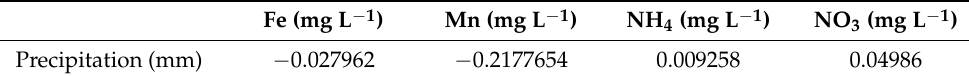
Table 4. Correlation coefficients between average annual concentrations of iron, manganese, ammo- nium, and nitrate in groundwater and the amount of annual precipitation in the period 1984–2015.